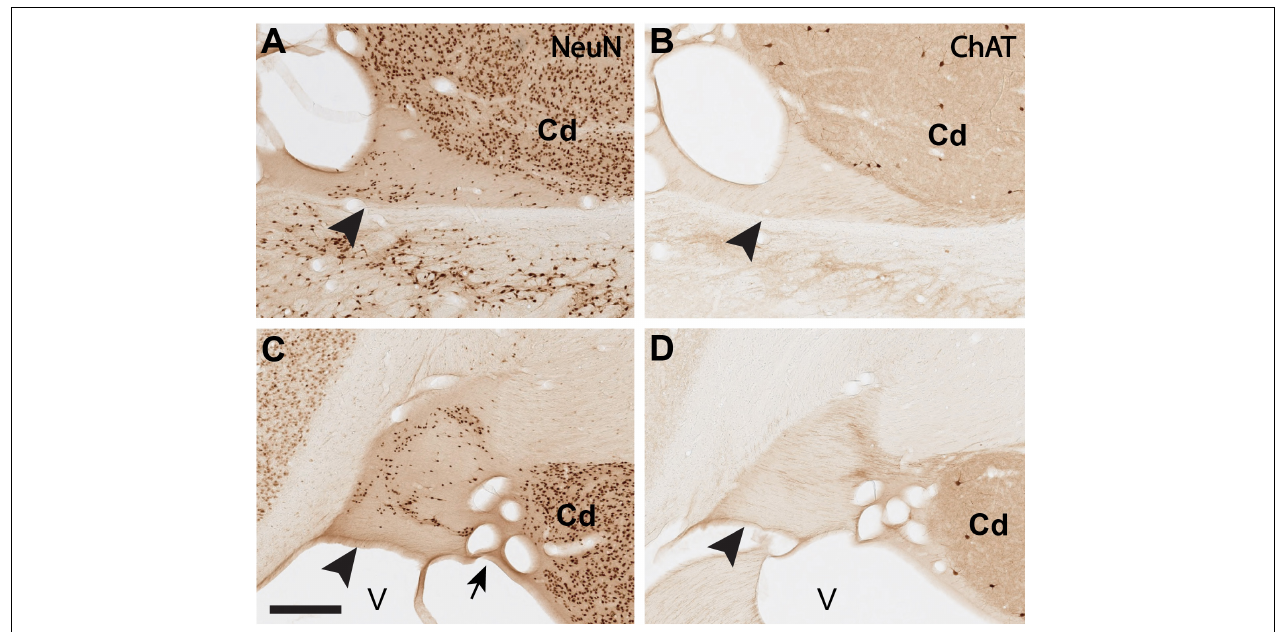
FIGURE 2 | Delineation of the ST-Cd border is aided by comparison of immuno-labeling for NeuN (A,C) and ChAT (B,D) , where the ST is comparatively poor in ChAT. (A,B) : Closely adjoining coronal sections ( < 1.0 mm apart) of the dST (arrowheads) reacted for NeuN (A) or ChAT (B) . (C,D) : Closely adjoining sections ( < 1.0 mm apart) of the vST (arrowheads) reacted for NeuN (C) or ChAT (D) . Medial is to the left. Arrow in panel (C) points to a cluster of blood vessels, cut in cross section. Cd, caudate; V, lateral ventricle. Scale bar, 400 µ m. For reference, panel A corresponds to B61 NeuN section 35. Panel (C) corresponds to B61 NeuN section